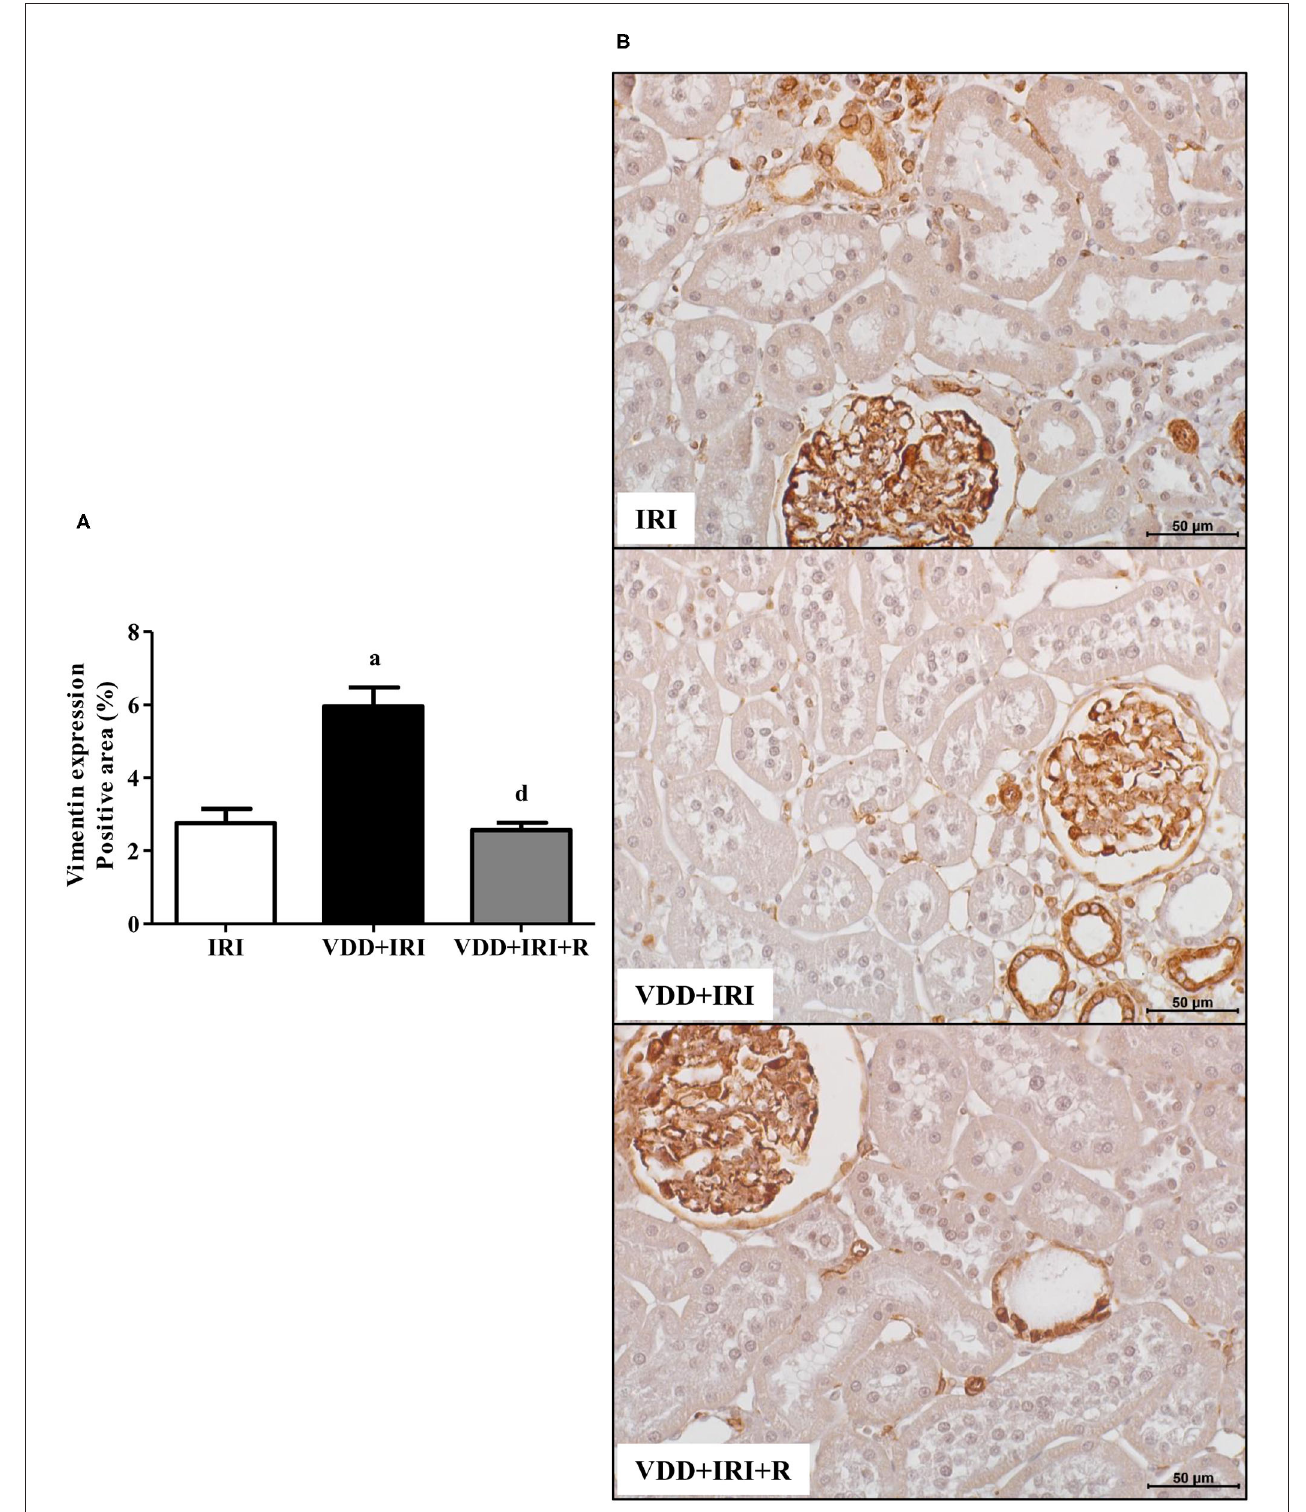
FIGURE 8 | Immunohistochemical analysis for vimentin expression in the kidney tissue evaluated 90 days after ischemia/reperfusion insult (IRI) on day 30. (A) Bar graph of vimentin expression values. (B) Representative photomicrographs of immunostaining for vimentin in the renal cortex from an IRI, VDD + IRI and VDD + IRI + R rat ( × 400). Note that vitamin D replacement restored the expression of vimentin in the VDD + IRI + R rats. Data are mean ± SEM. a p < 0.001, vs. IRI; d p < 0.001 vs. VDD + IRI. VDD: vitamin D deficiency; R: vitamin D replacement. Diet protocol: IRI, standard diet for 120 days; VDD + IRI, vitamin D-free diet for 120 days; and VDD + IRI + R, vitamin D-free diet in the first 30 days and standard diet in the last 90 days.